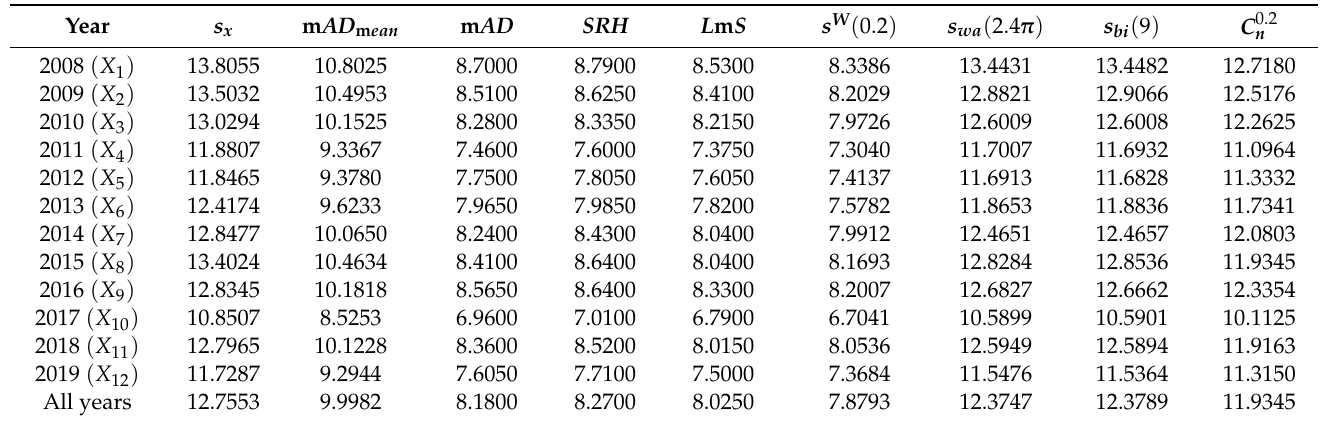
(cid:16) (cid:17) µ g/m 3